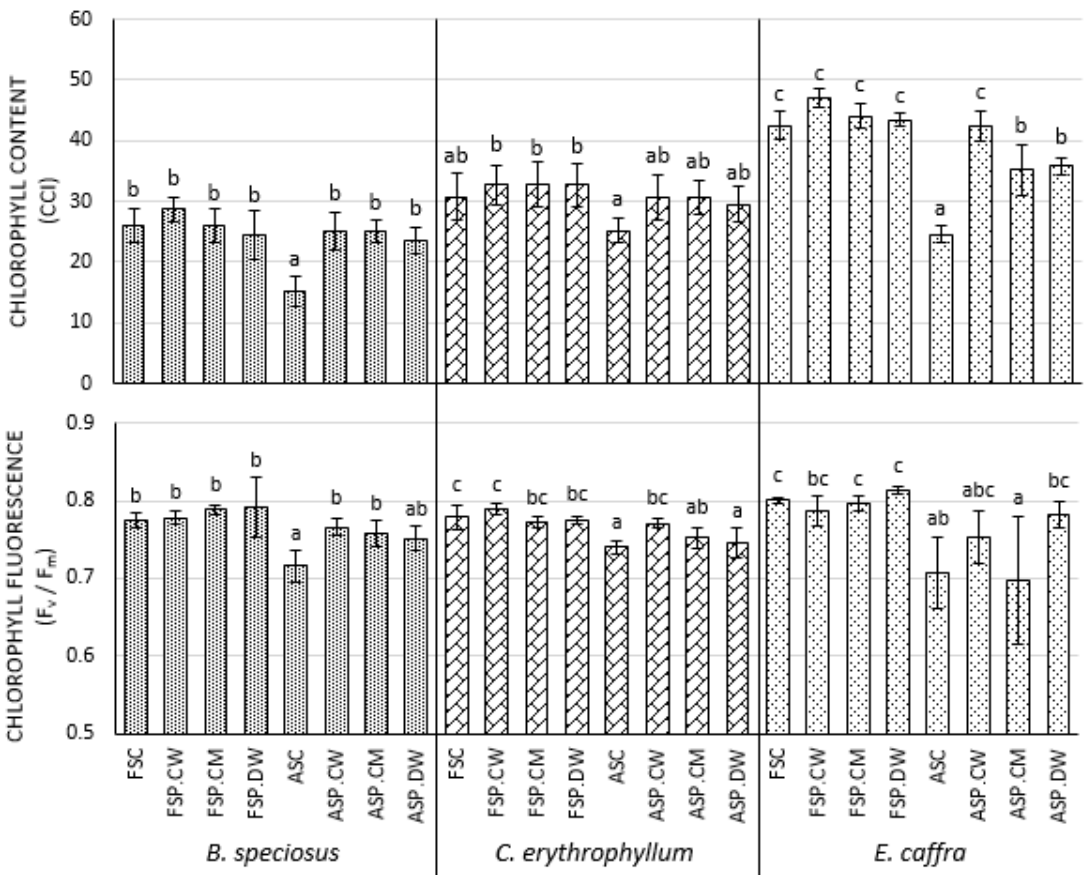
Figure 1. Effect of cathodic water, calcium magnesium solution and deionized water seed invigoration on the chlorophyll fluorescence and chlorophyll content in the leaves of Bolusanthus speciosus , Combretum erythrophyllum and Erythrina caffra . Bars with different letters in each species and for each parameter (chlorophyll content/ chlorophyll fluorescence) investigated are significantly different ( p < 0.05). FSC = fresh seeds that were neither aged nor primed; ASC = seeds that were aged but not primed; FSP.CW = fresh seeds primed with cathodic water; FSP.CM = fresh seeds primed with calcium magnesium solution; FSP.DW = fresh seeds primed with deionized water; ASP.CW = aged seeds primed with cathodic water; ASP.CM = aged seeds primed with calcium magnesium solution; ASP.DW = aged seeds primed with deionized water.